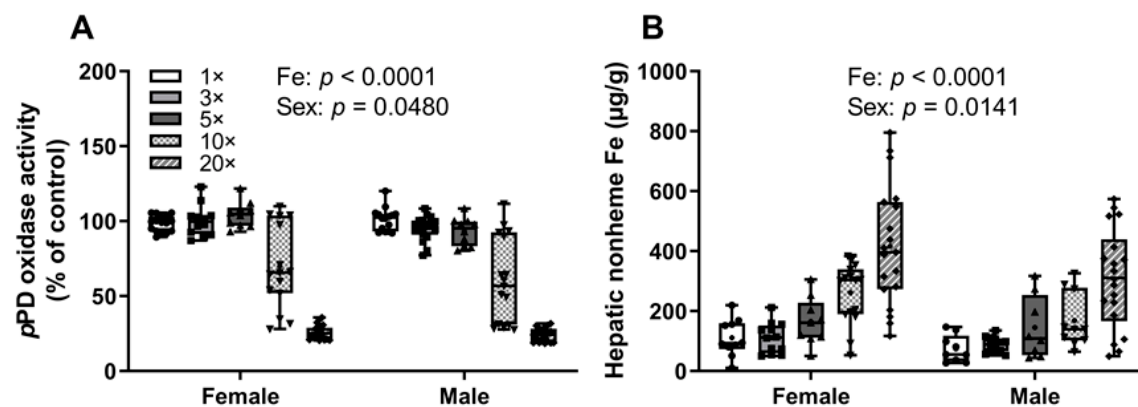
Figure 2. High-iron consumption by previously iron-deficient rat dams decreases serum p PD oxidase activity and increases hepatic nonheme iron content in their offspring. Serum p PD oxidase activity ( A ) and hepatic nonheme iron content ( B ) of 13–15-day-old pups are shown. Pups were suckling rat dams fed diets varying only in iron concentration for ~5 weeks, starting around the time of conception. Results were analyzed by two-way ANOVA; no significant 2-way interactions were noted. Significant main effects are noted in each panel. All data points are shown, and the mean values are indicated by “+” signs.